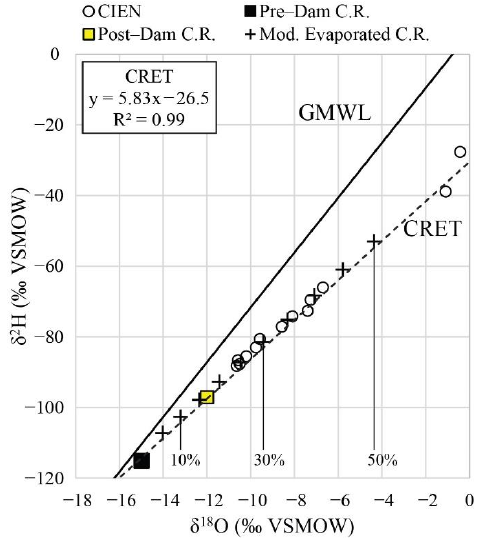
Figure 6. δ 2 H vs. δ 18 O showing modeled evolution of Colorado River water evaporating under 60% relative humidity (mod. evaporated Colorado River). Also shown: data for surface water from the Ciénega (labeled CIEN), average pre-dam Colorado River water, average post-dam Colorado River water, the GMWL, and the CRET. Percentages indicate the degree of evaporation relative to pre- dam river water.